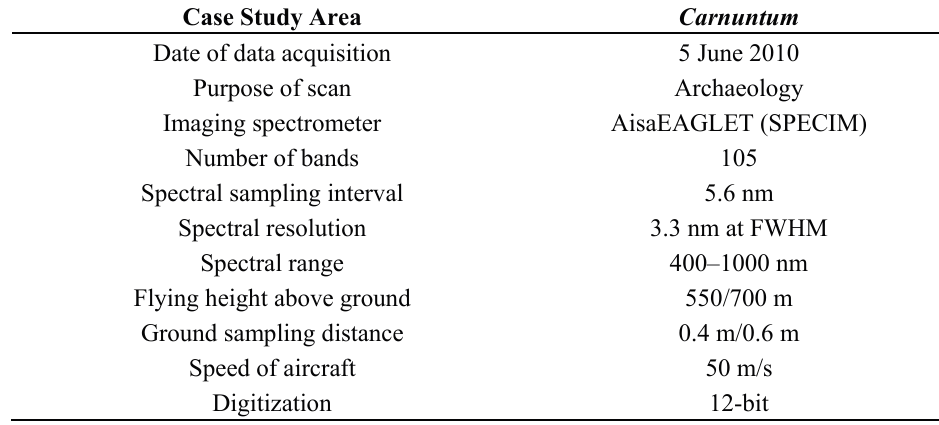
Table 2. Flight parameters of the AIS data acquisition campaigns over the case study area of Carnuntum , Lower Austria (FWHM means Full Width at Half